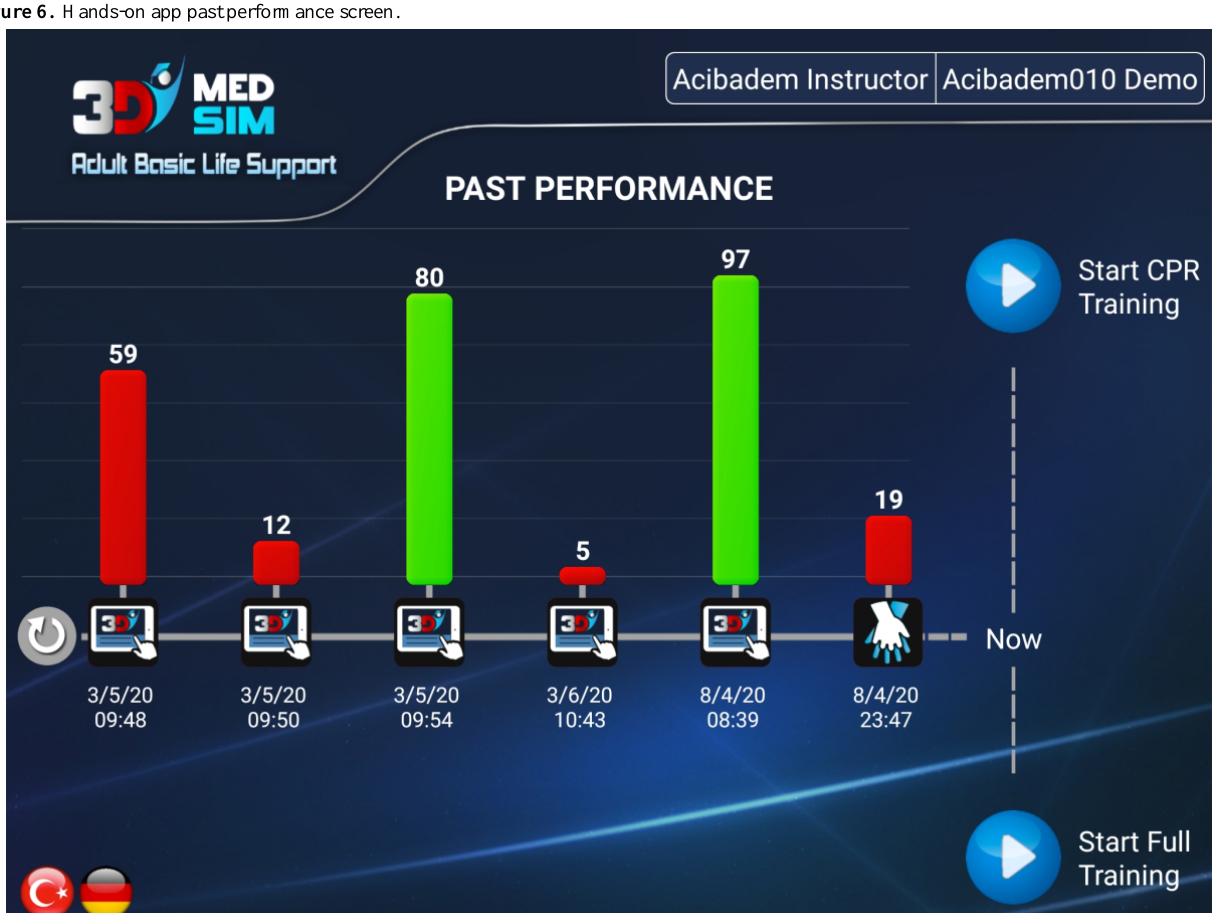
Figure 6. Hands-on app past performance